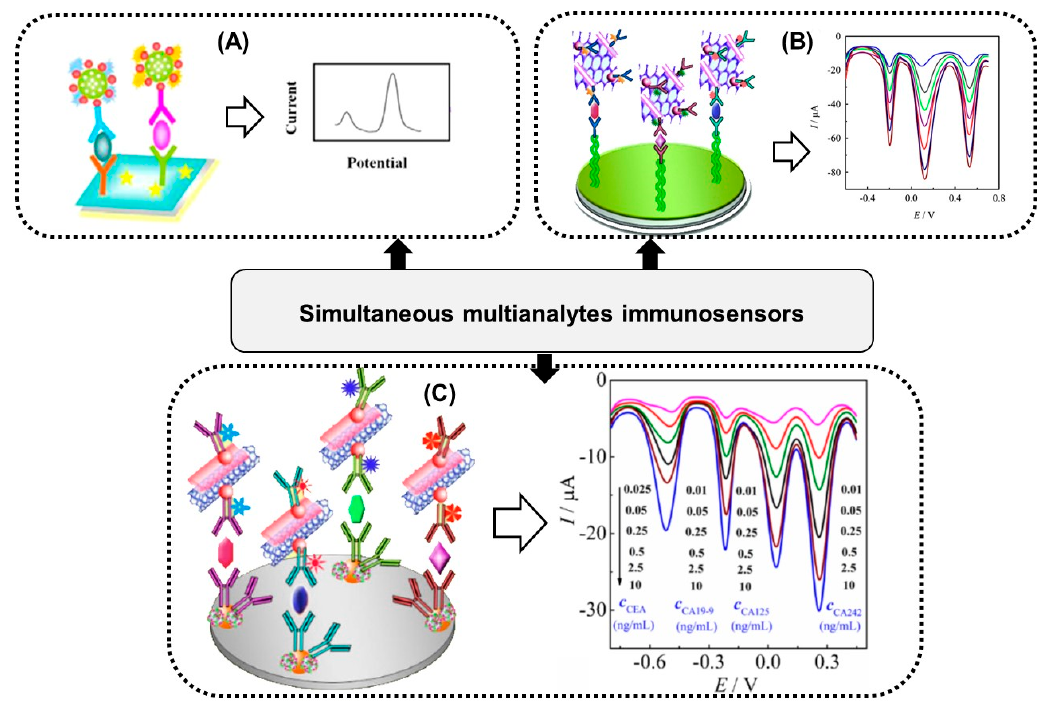
Figure 5. Schematic illustrations of immunosensors based on a multi-electroactive probe strategy. ( A ) simultaneous detection of two analytes using neutral red and thionine labels conjugated to specific antibodies (reprinted with permission from Wu et al. [63]). ( B ) Simultaneous detection of three analytes using thionine, ferrocenecarboxylic acid, and tris(2,2`-bipyridine-4,4`-dicarboxylic acid)cobalt(III) labels conjugated to specific antibodies (reprinted with permission from Zhu et al. [65]). ( C ) Simultaneous detection of four biomarkers using anthraquion-one 2-carboxylic acid, thionine, ferrocenecarboxylic acid, and tris(2,2`-bipyridine-4,4`-dicarboxylic acid)cobalt(III) labels conjugated to specific antibodies (reprinted with permission from Zhu et al. [67]).